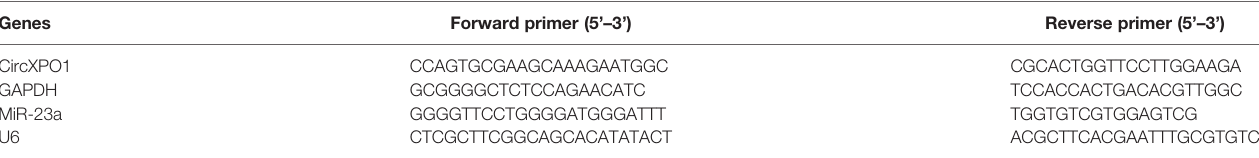
TABLE 2 | Primer sequences for quantitative real-time